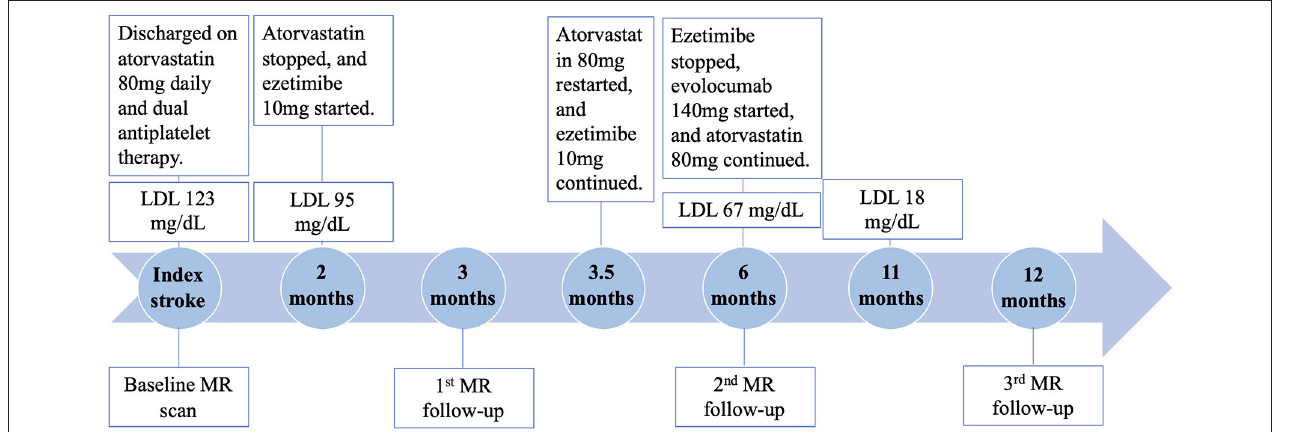
FIGURE 3 | Timeline of clinical management and MR